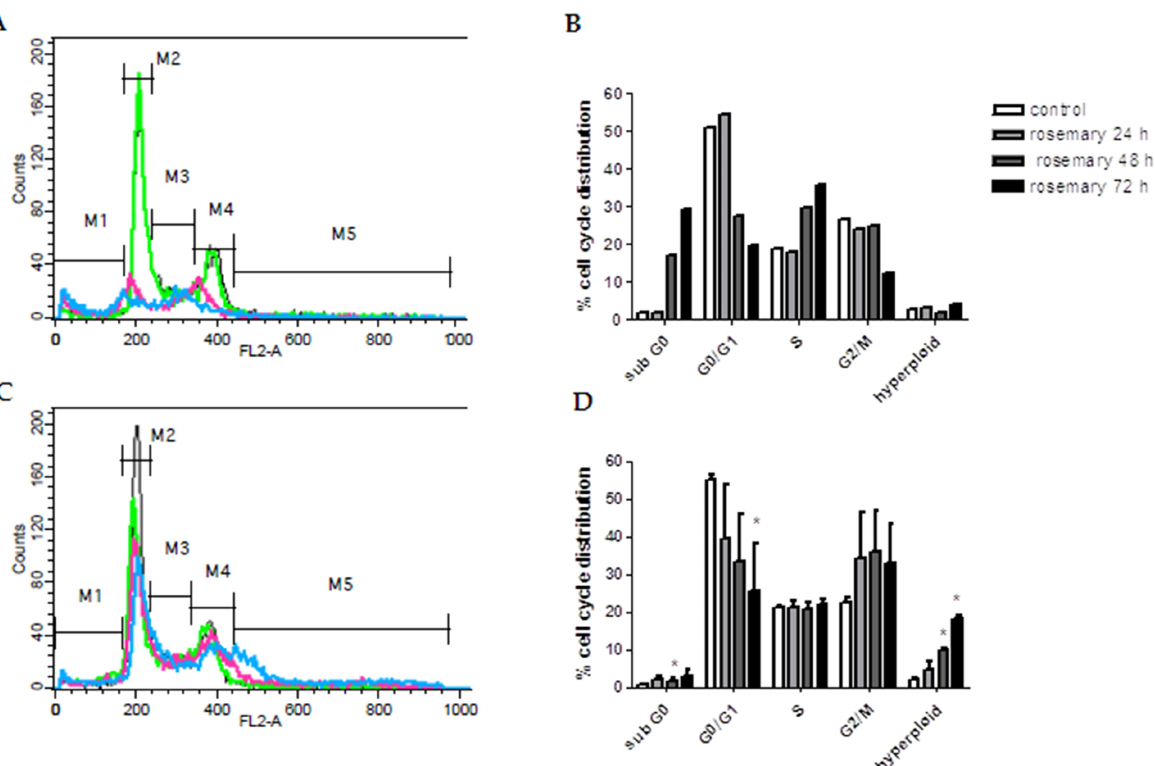
Fig 4. Cell cycle analysis of A375 melanoma cells treated with Rosmarinus officinalis extract. The figure shows the DNA content flow cytometric histograms of A375 cells (A-C) and the corresponding percentages of cell cycle distribution after treatment with Rosmarinus officinalis extract (B-D). Plots A and C show vehicle treated cells (black line) and cells treated for 24 (green line), 48 (fuchsia line) and 72 h (blue line) with 1:120 and 1:240 dilutions of Rosmarinus officinalis extract. M1, M2, M3, M4 and M5 are representative virtual markers of subG0/G1, G0/G1, S, G2/M and hyperploid phases of cell cycle, respectively. After treatment, cells were stained with propidium iodide and flow cytometric analysis was performed as described in Materials and Methods. The data shown in A and C are representative of three independent analyses. Results shown in B and D are the mean ± SD from three independent experiments. * P (cid:1) 0.05 versus vehicle treated control